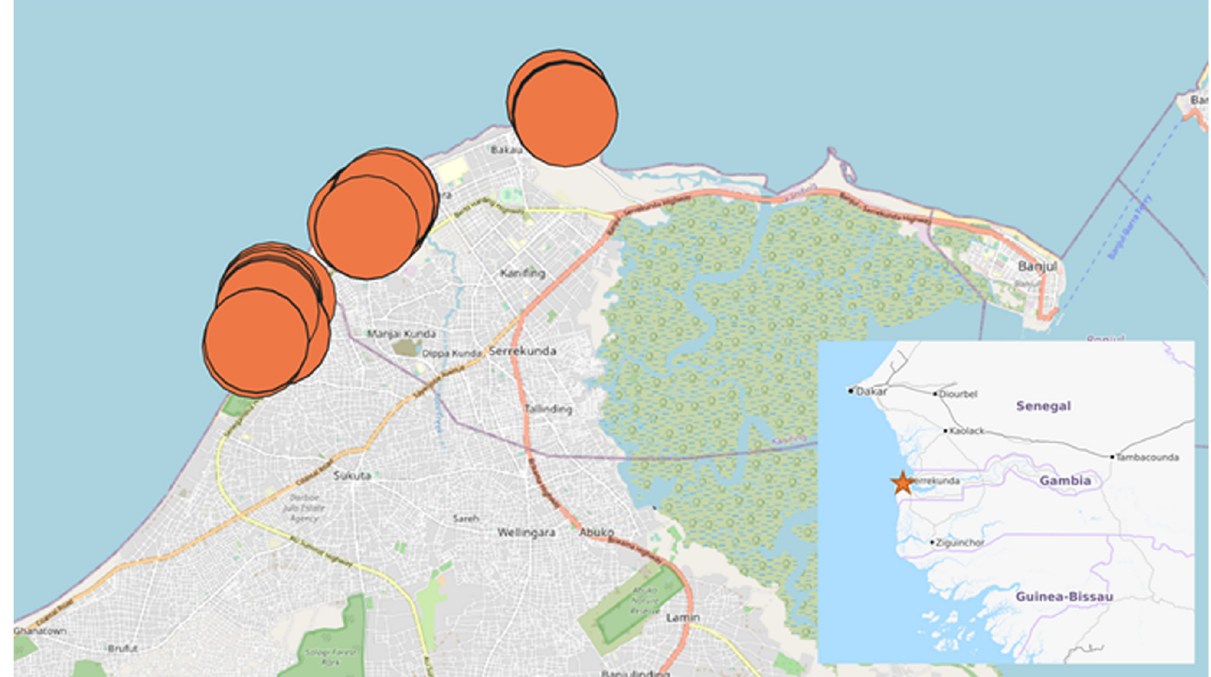
Fig 1. Data collection locations. Map data © OpenStreetMap (openstreetmap.org/copyright), used under a Creative Commons license, available at https://www.openstreetmap.org/#map=13/13.4183/-16.6817. Red circles display interview sites and are shown as randomly offset large circles to maintain